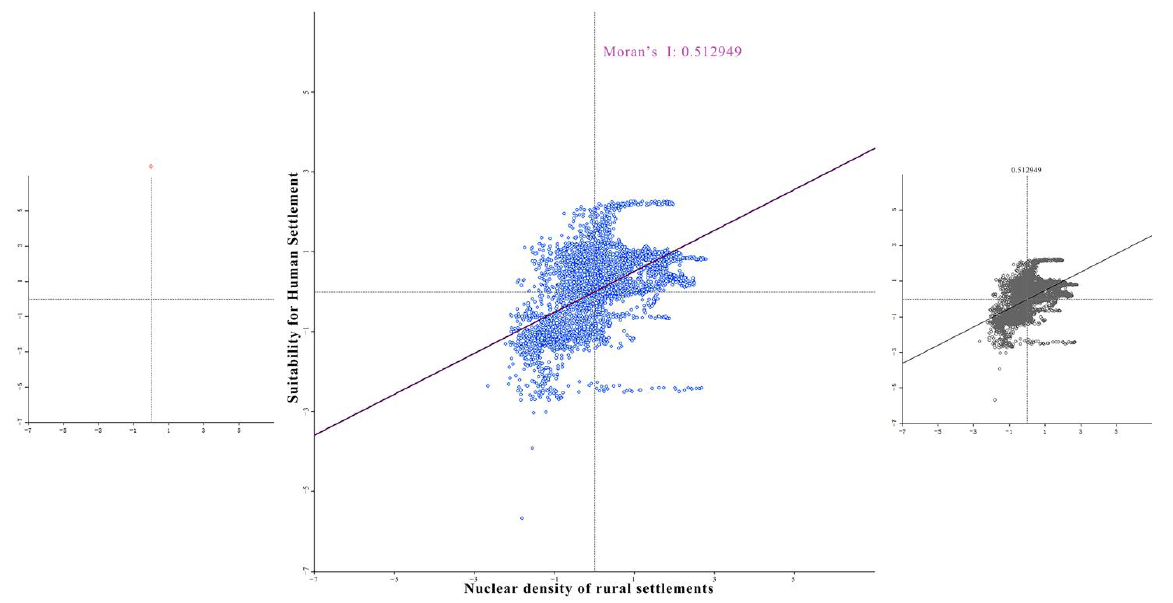
Figure 6. Spatial global autocorrelation.